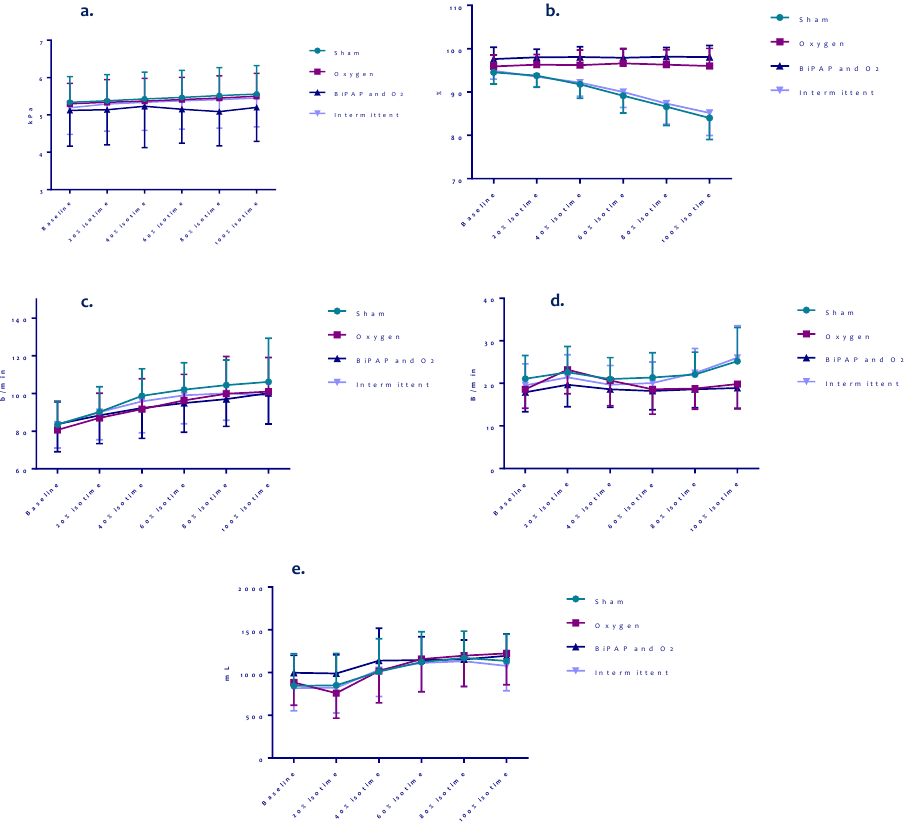
Figure 5. Isotime results on P a CO 2 , SpO 2 , heart rate, breathing frequency and tidal volume of di ff erent settings during bout 1 of all patients. ( a ) P a CO 2 test 1, ( b ) SpO 2 test 1, ( c ) Heart rate test 1, ( d ) Breathing frequency test 1, ( e ) Tidal volume test 1.